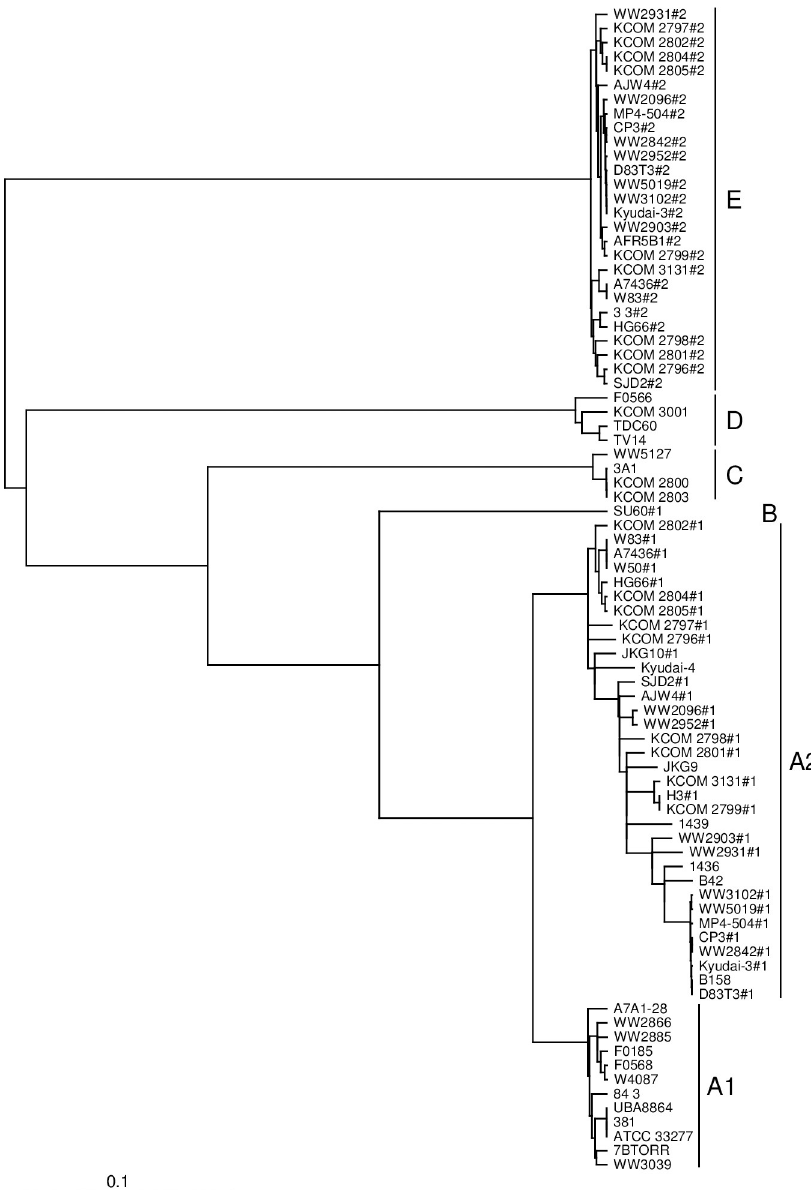
Fig 3. Phylogenetic tree of the mfa5 gene. A phylogenetic tree was constructed with TreeView X through a multiple sequence alignment analysis using Clustal O . The mfa5 gene is primarily classified into 5 genotypes of A, B, C, D, and E. Additionally, genotype A forms 2 clusters, called genotypes A1 and A2. Strain names appending with either #1 or #2 indicate the first and second mfa5 ,